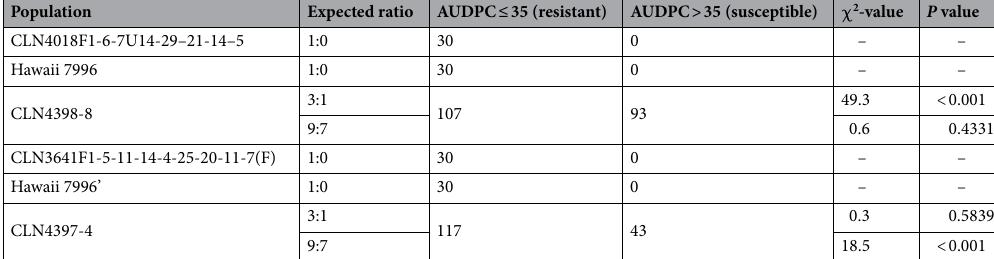
Table 3. Goodness of fit test for inheritance of resistance to the Pss4 isolate of bacterial wilt (race 1, biovar 3, Ralstonia pseudosolanacearum ) for the two F 2 populations (CLN4398-8 and CLN4397-4) derived